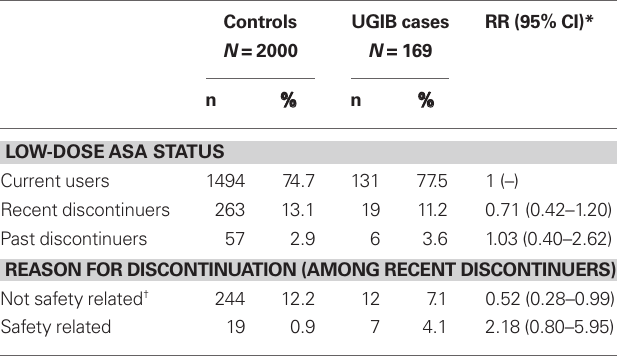
Table 3 | The prevalence of low-dose ASA discontinuation in individuals with ugiB and controls with no ugiB, and its association with a diagnosis of ugiB, in a cohort of low-dose ASA